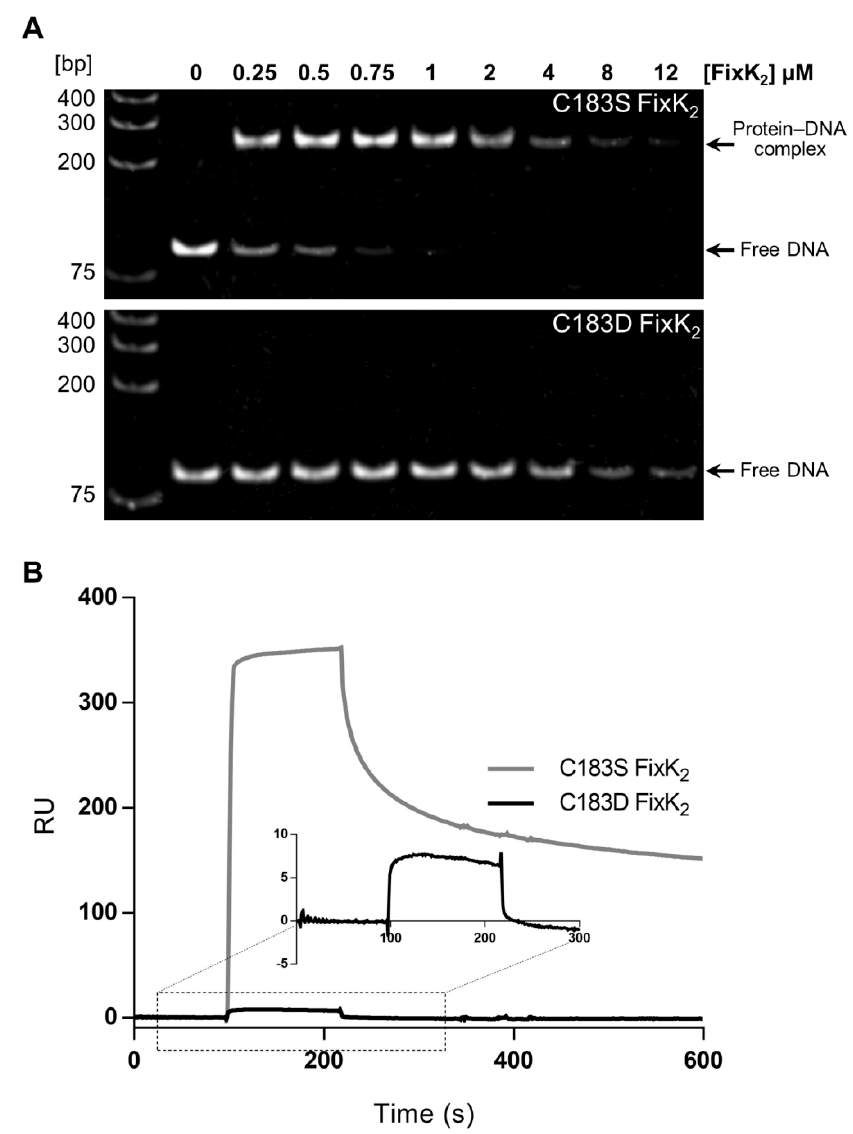
Figure 3. In vitro interaction of C183S and C183D FixK 2 derivatives with the fixNOQP promoter tested by EMSA ( A ) and surface plasmon resonance (SPR) ( B ) approaches. ( A ) A 90-bp PCR fragment containing the FixK 2 box at 20 nM was incubated with increasing concentrations (0 to 12 µM) of FixK 2 protein variants, indicated at the top of each gel. Lower bands show free DNA, while upper bands correspond to the protein–DNA complexes. The molecular marker GeneRuler™ 1 Kb Plus DNA Ladder (Thermo Fisher Scientific, Waltham, MA, USA) is shown on the first lane. ( B ) A biotinylated double-stranded oligonucleotide containing the FixK 2 box from the fixNOQP promoter was immobilized on a streptavidin (SA) sensor chip by biotin–streptavidin binding. The sensorgrams with the relative resonance units (RU) of the interaction with DNA of C183S and C183D FixK 2 protein variants at 250 nM are shown. Data of the C183D FixK 2 protein did not allow us to calculate any kinetic/affinity parameters.